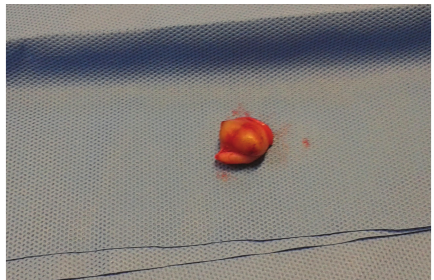
Figure 5: Umbilical nodule